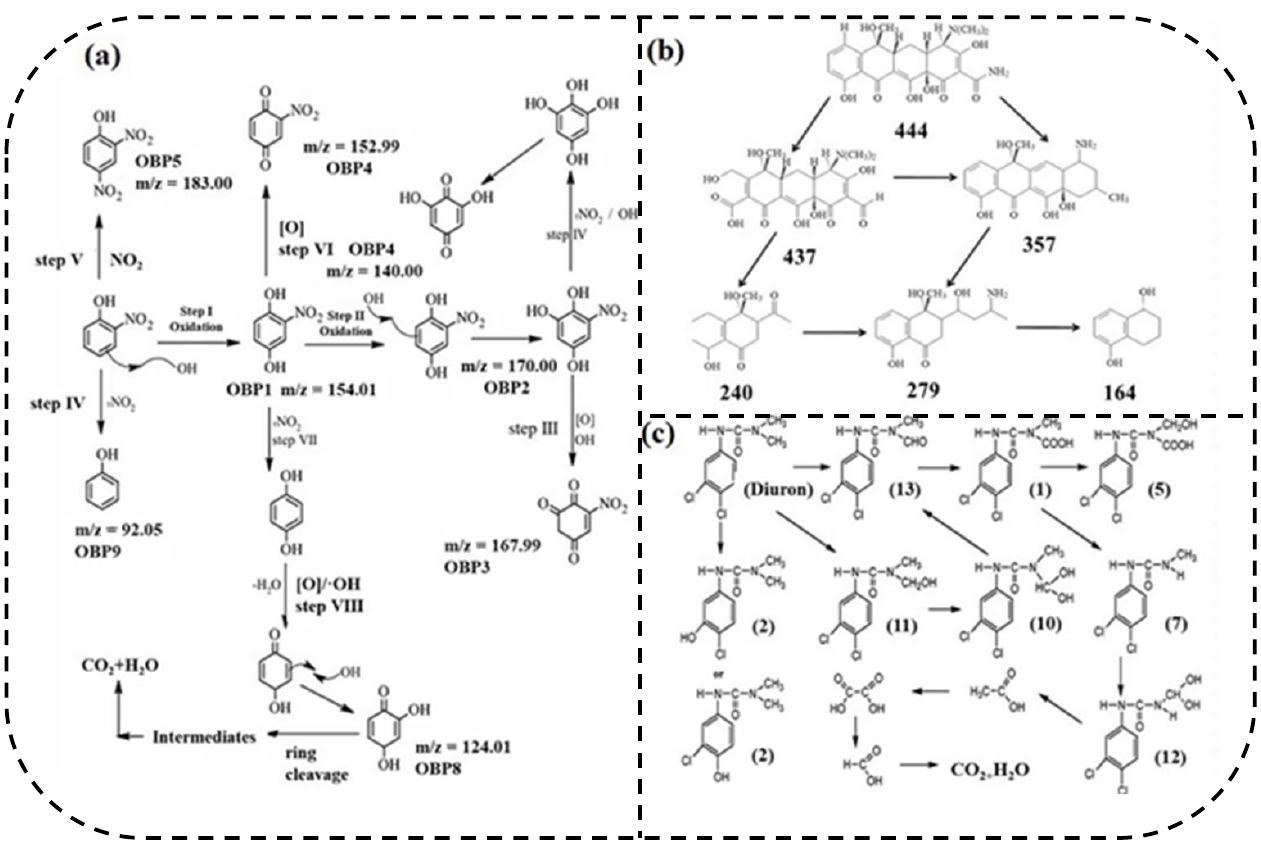
Figure 11. Degradation pathways of ( a ): 2-NP [48]; ( b ): Tetracycline [102]; ( c ): Dailon [80].